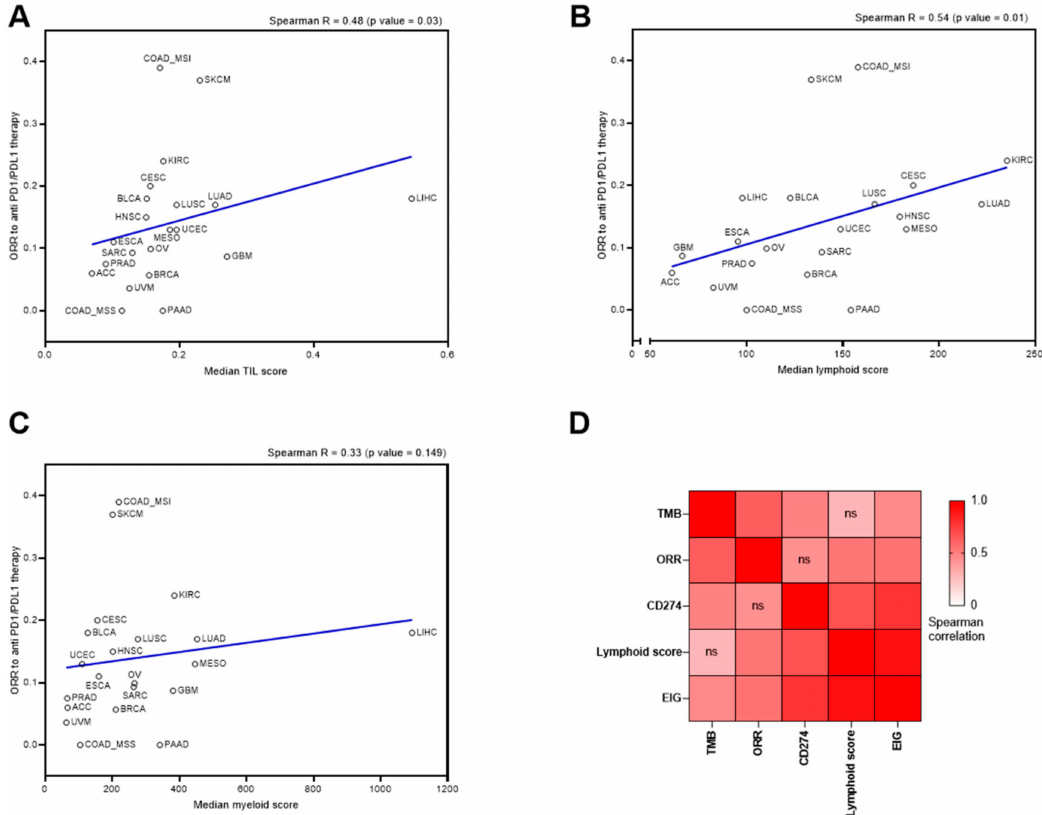
Figure 4. Evaluation of the predictive role of the TIL and lymphoid scores in the Pan-Cancer TCGA cohort. ( A – C ): Correlation of median TIL ( A ), myeloid ( B ), and lymphoid ( C ) scores with objective responserate(ORR)toanti-PD-1 / PD-L1therapyacross21TCGAcancertypes. ( D ):Spearmancorrelation matrix estimated for lymphoid score, TMB, CD274 gene expression, expanded immune gene (EIG) signature, and objective response rate (ORR) to anti-PD-1 / PD-L1 therapy. Correlations were computed across 21 TCGA cancer